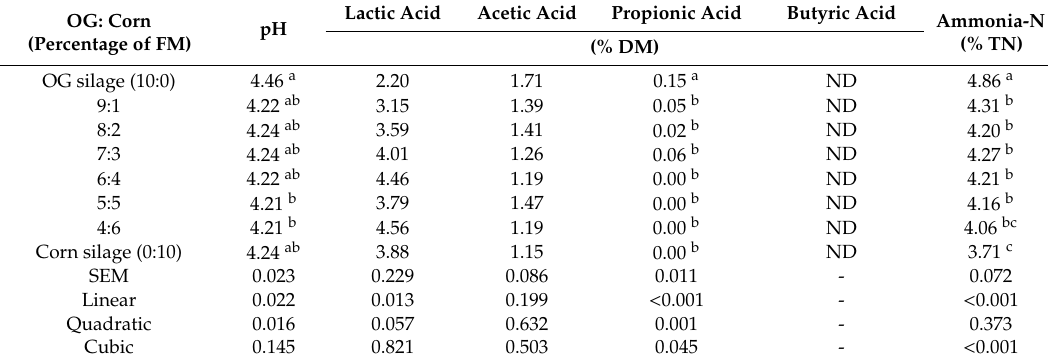
Table 3. Fermentation quality of Oxytropis glabra (OG) mixed with whole-plant corn after 60 d of